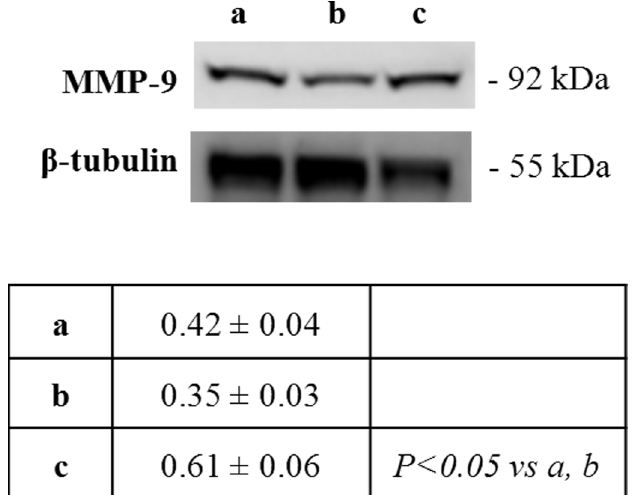
Figure 4. Severe hyperoxia increases liver expression of MMP-9. Western blotting analysis of MMP-9 expression in neonatal rat livers exposed to moderate and severe hyperoxia. a) ambient air; b) 60% hyperoxia; c) 95% hyperoxia. Each membrane has been probed with anti-tubulin antibody to verify loading evenness. Data are the densitometric measurements of protein bands expressed as mean values of Integrated Optical Intensity (IOI) ( 6 SD).